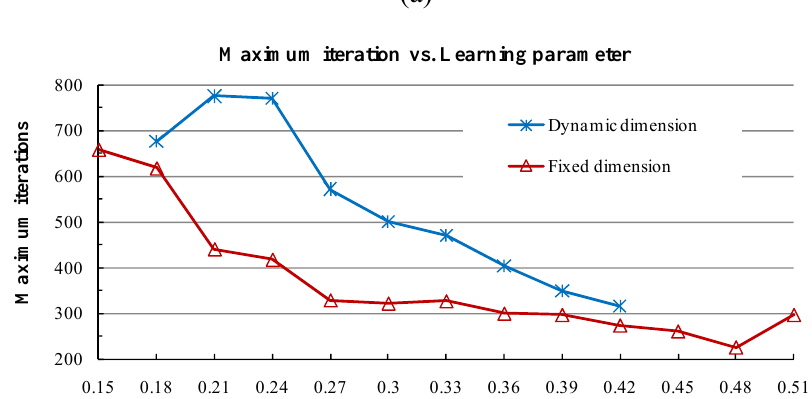
Learning parameters